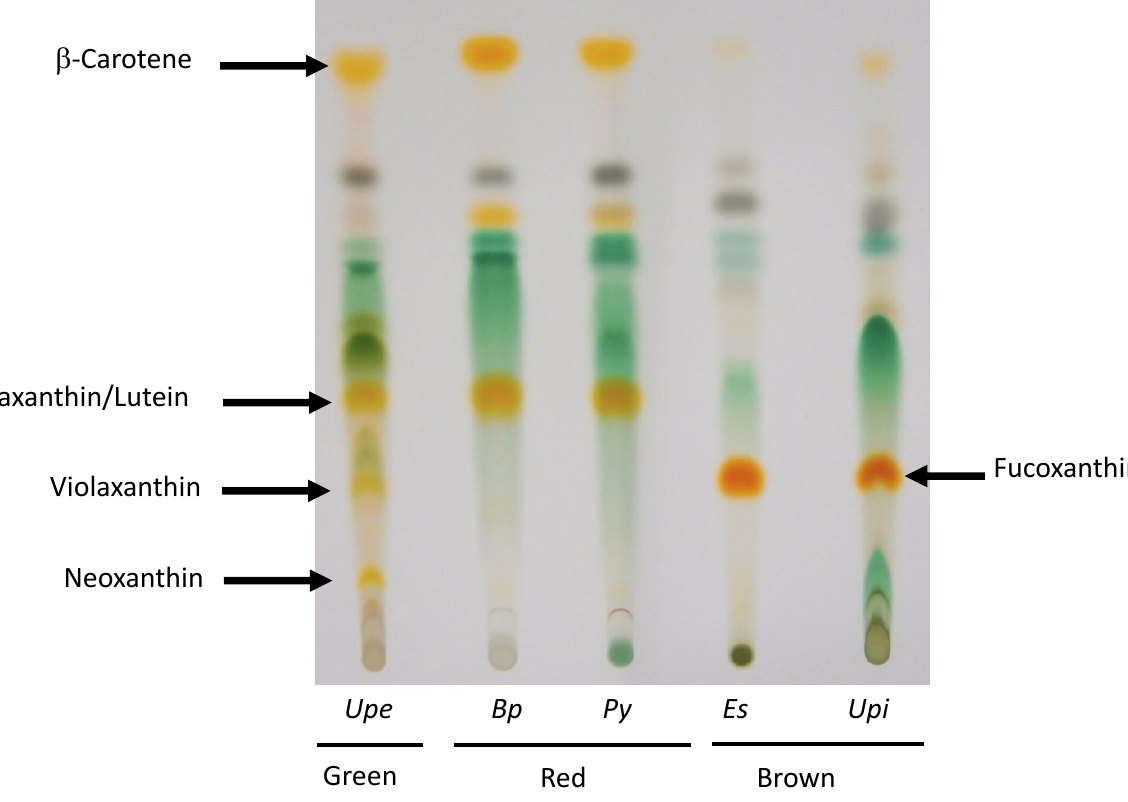
Figure 2. Thin-layer chromatography (TLC) analysis of carotenoids in seaweeds. Total lipids were extracted from the green seaweed, Ulva pertusa (Upe), red seaweeds, Bangia fuscopurpurea (Bf) and Porphyra yezoensis (Py), and brown seaweeds, Ectocarpus siliculosus (Es) and Undaria pinnatifida (Upi), with methanol. To detect each carotenoid contained in algae, total lipids were developed on a silica gel TLC plate with petroleum ether: acetone (7:3, v / v ). We have confirmed that violaxanthin and fucoxanthin can be distinguished by UV-Vis